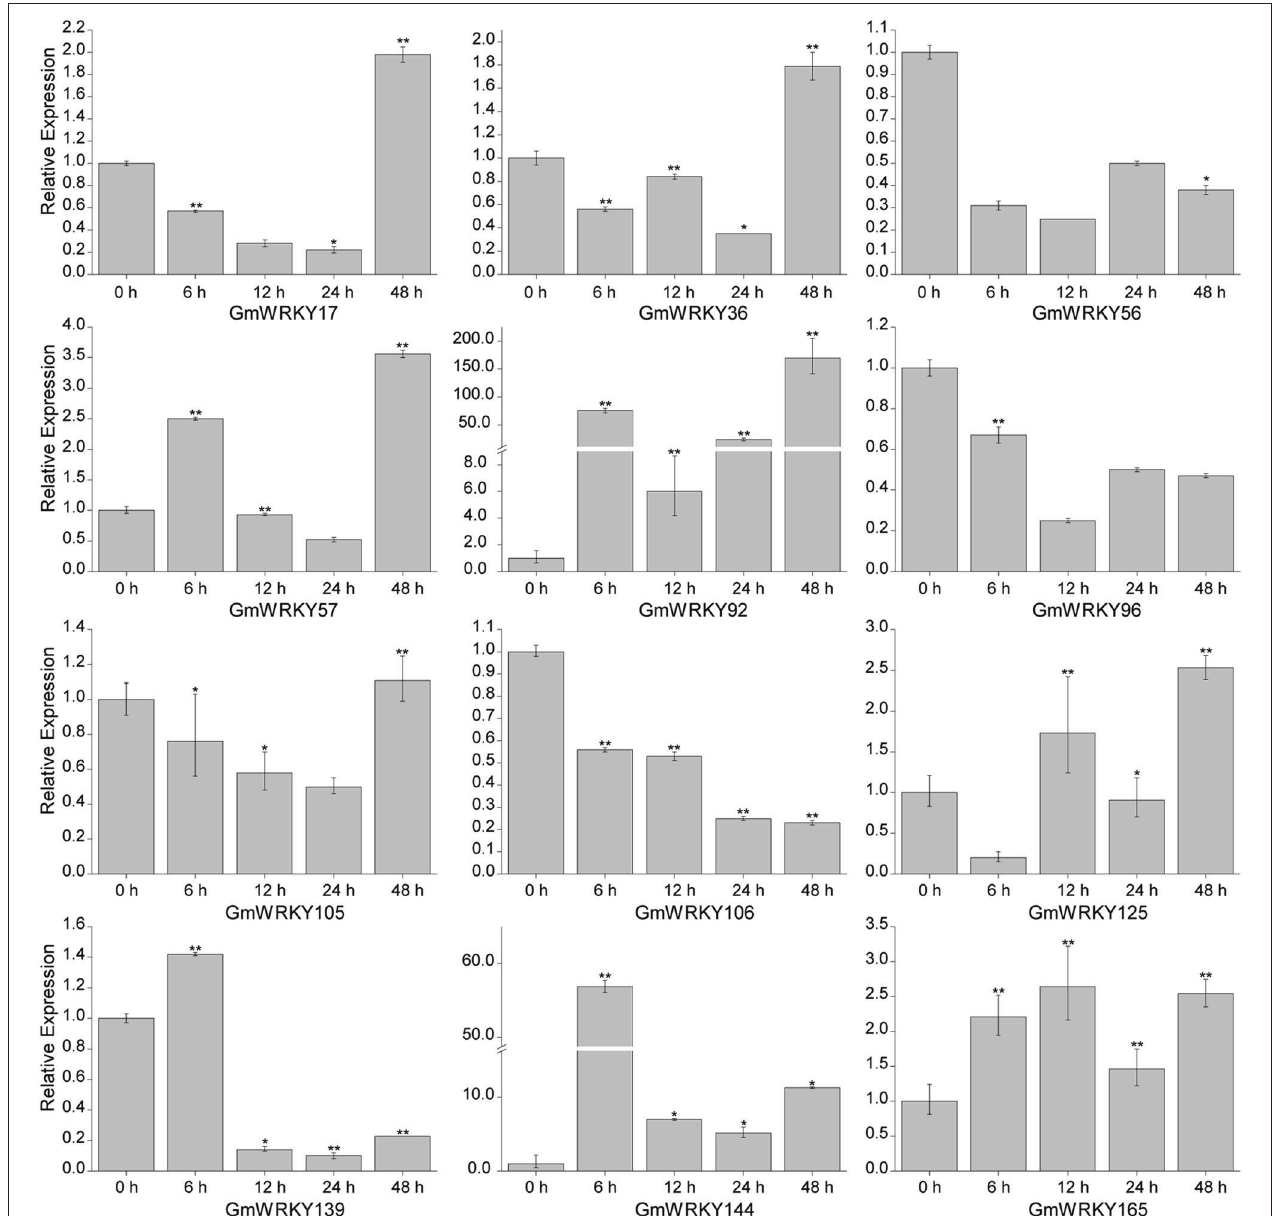
FIGURE 11 | Expression pattern of selected GmWRKY genes under salt stress. The Y-axis indicates the relative expression; X-axis (0, 6, 12, 24, and 48h) indicates hours of salt treatment. The standard errors are plotted using vertical lines. * significant difference at P < 0.05 , ** significant difference ( P < 0.01 ).